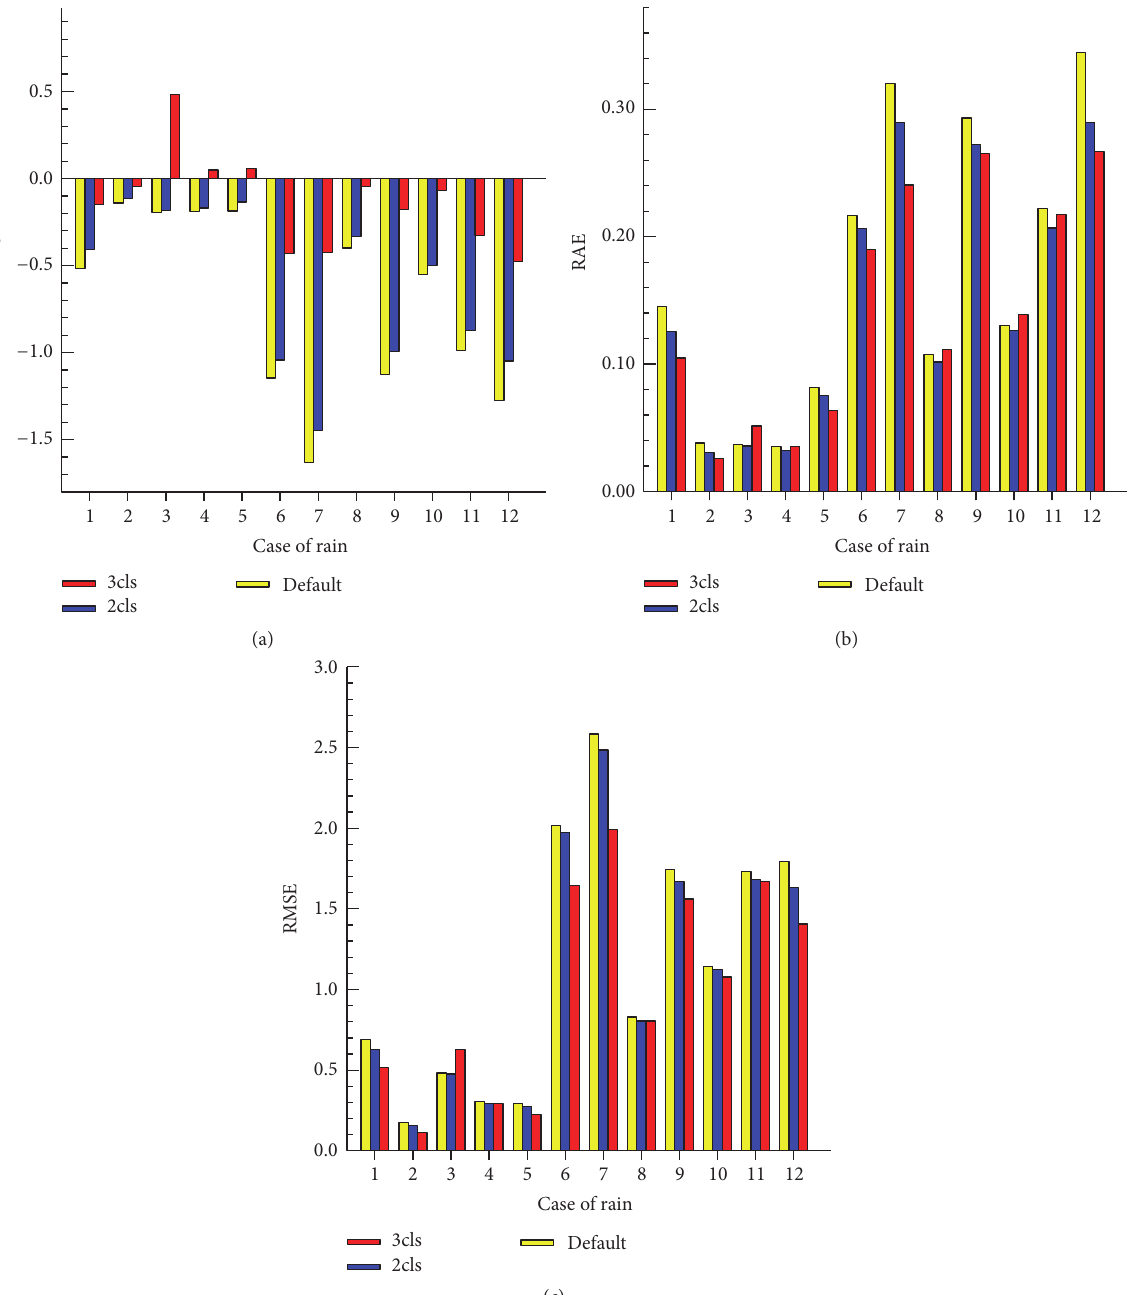
Figure 3: Error statistics considering all stations, for each precipitation process. Label “2cls” represents classification in two precipitation classes (Experiment II), and “3cls” represents classification in three precipitation classes (Experiment III). The units of BIAS and RMSE are mm; RAE is